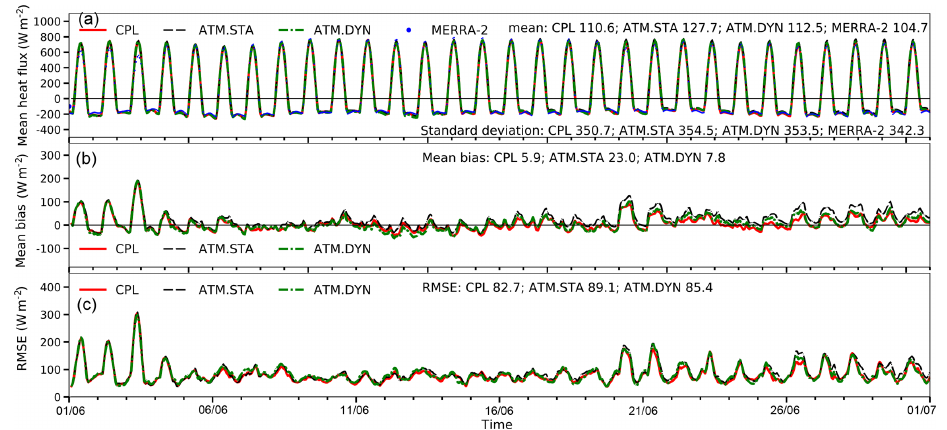
Figure 11. The total surface heat fluxes into the sea obtained in CPL, ATM.STA, and ATM.DYN in comparison with MERRA-2. Panel (a) shows the mean surface heat flux; (b) shows the mean bias; (c) shows the RMSE. Only the heat fluxes over the sea are